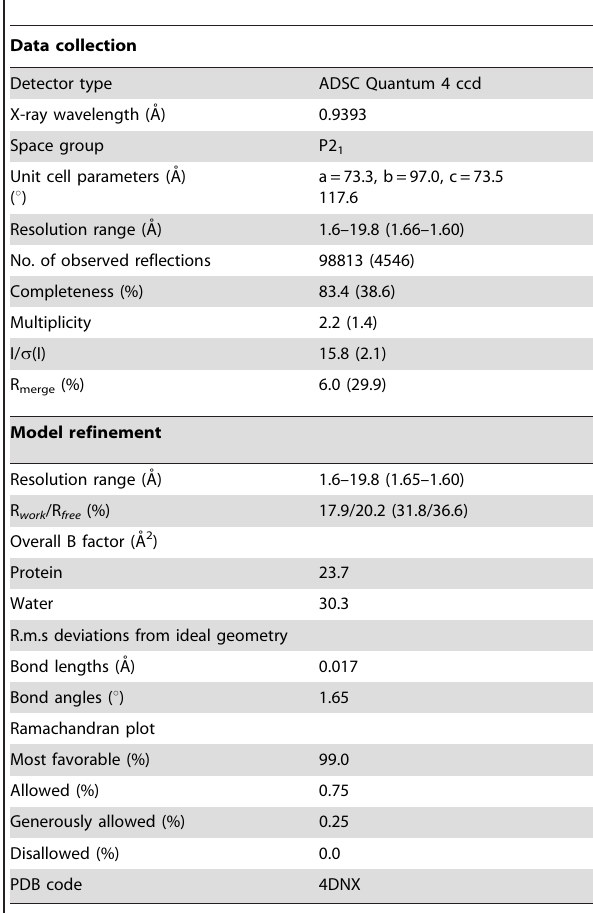
Table 1. Data collection and refinement